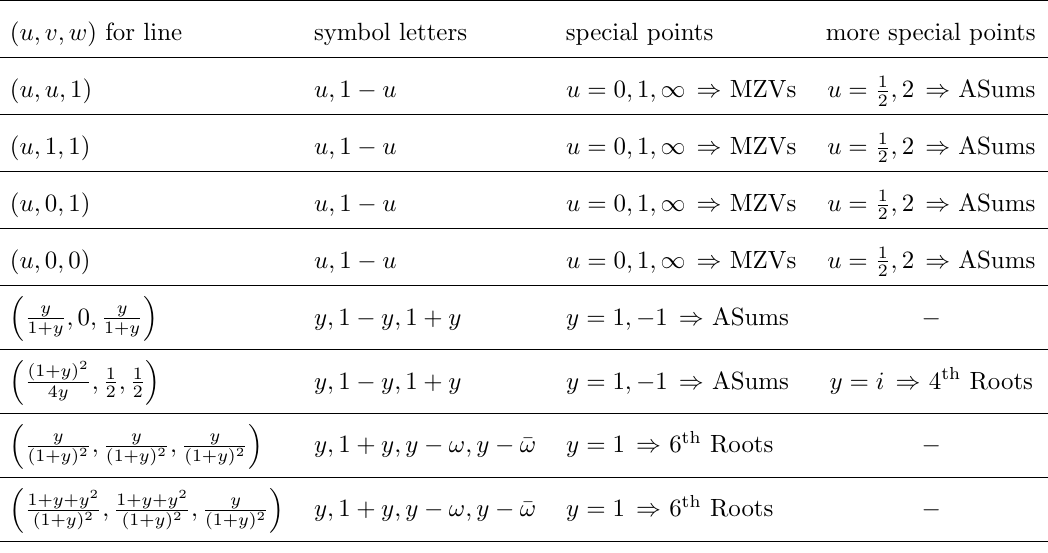
Table 12 . Examples of special lines through the space of cross ratios where the function space collapses to cyclotomic polylogarithms, and special points where the functions evaluate to MZVs or generalizations thereof. Here ! = exp(2 (cid:25)i= 3), (cid:22) ! = exp( (cid:0) 2 (cid:25)i=